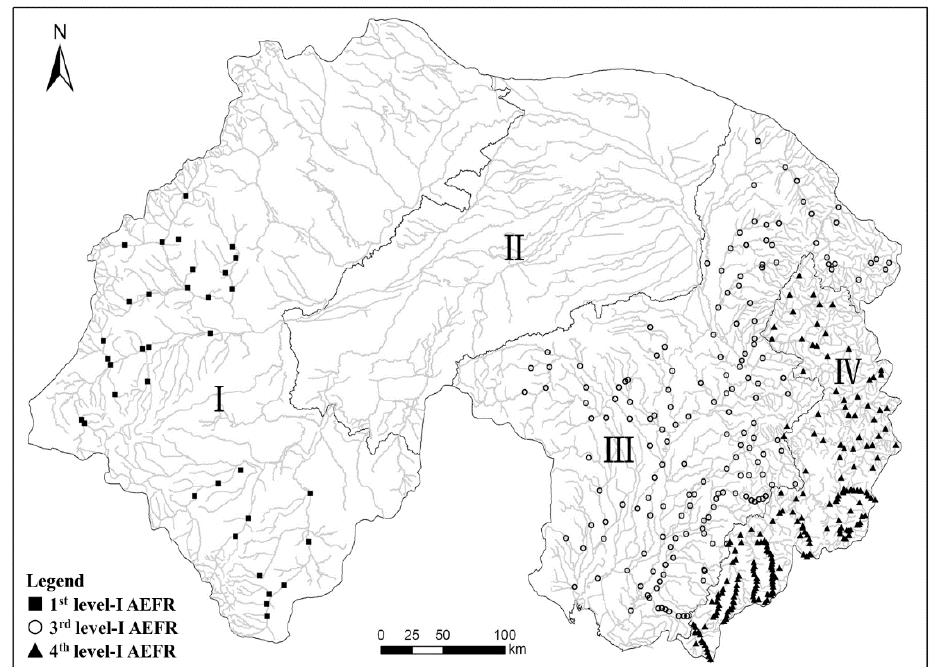
Figure 1. Map of study area and distribution of 407 sampling sites.